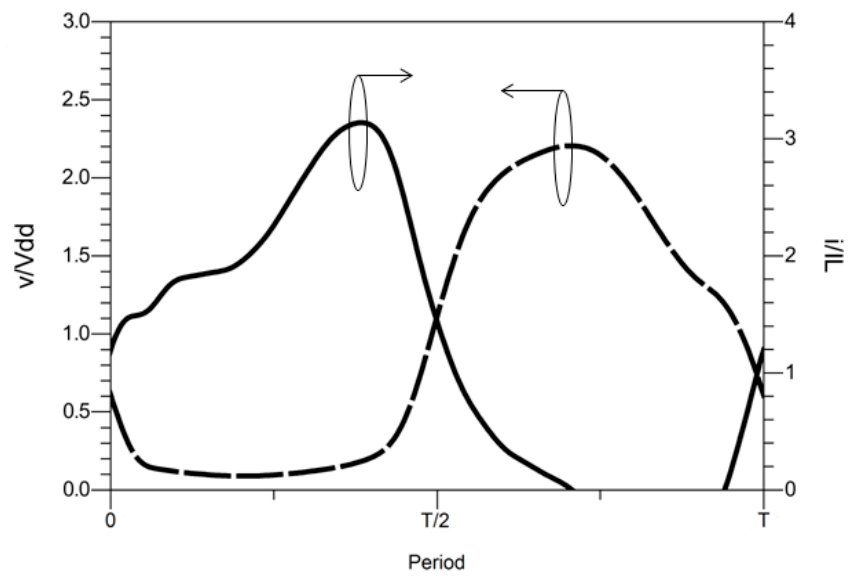
Figure 3. Simulated normalized switching waveforms.